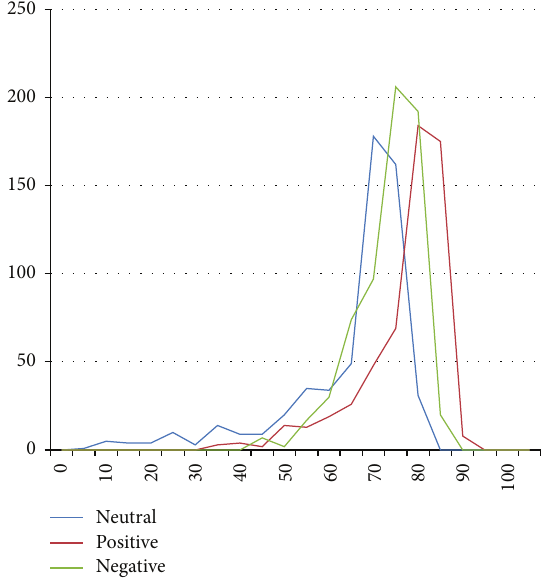
Figure 14: Distribution function for Pitch values for speaker DC. Table 8: Highest DR values for group numbers 1 to 4. Group number Positive effective